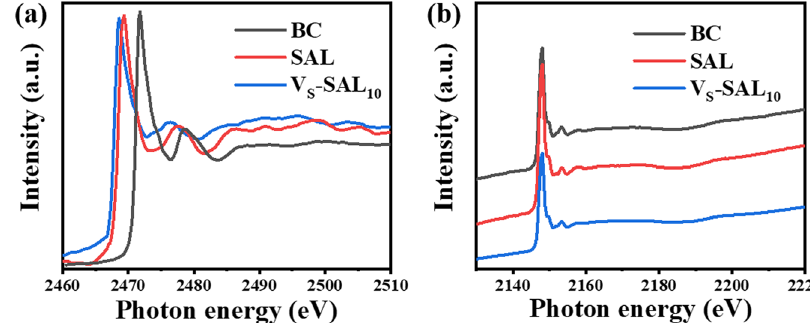
Fig. 2 XANES spectra of BC, SAL, and Vs-SAL10. a S and b P K-edge XANES spectra of BC, SAL, and